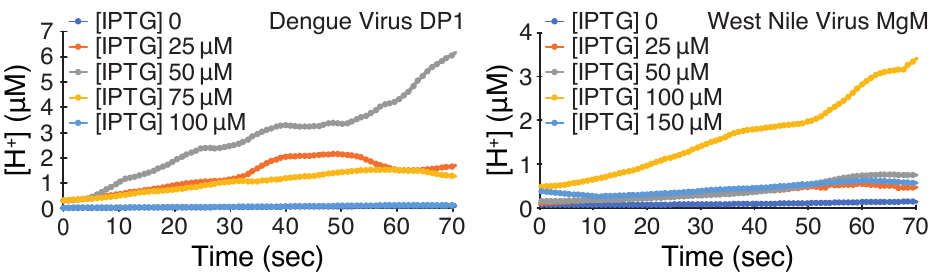
Figure 3. Acidity assay of Dengue Virus DP1 and West Nile Virus MgM viroporins. Cytoplasmic H + concentration is monitored as a function time whereby at time 0, an acidic solution is injected into the media. Results are shown from bacteria in which viroporin induction is changed as a function of IPTG concentration as noted.